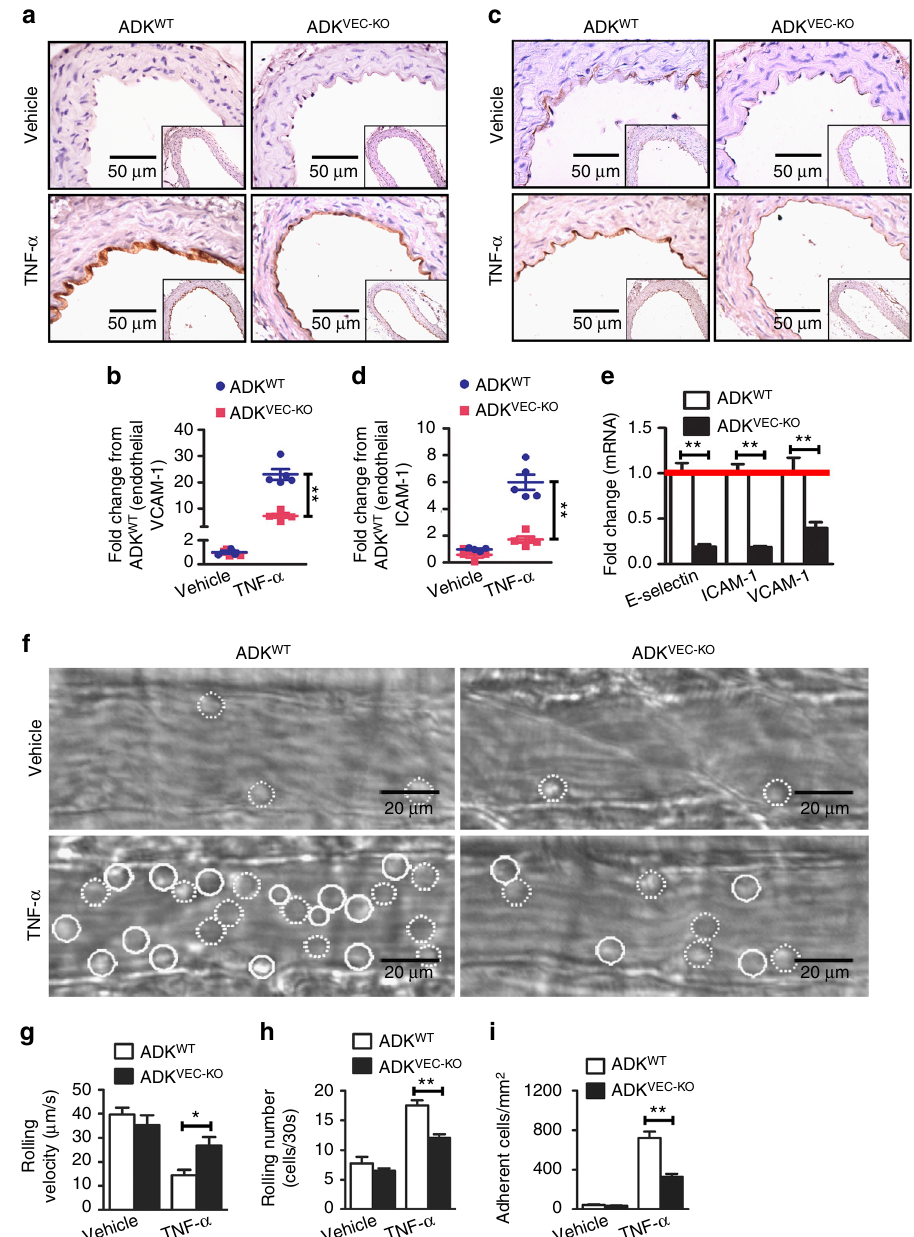
Fig. 3 ADK de fi ciency suppresses endothelial in fl ammation in vivo. a Representative images for immunohistochemical staining of VCAM-1 in aortas from TNF- α -treated ADK WT and ADK VEC-KO mice ( scale bar , 50 µ m). b Quanti fi cation of VCAM-1 expression in aortas from TNF- α -treated ADK WT and ADK VEC-KO mice and the graph shows the data as fold change compared with the vehicle-treated ADK WT mice ( n = 4 – 5 mice per group). c Representative images for immunohistochemical staining of ICAM-1 in aortas from TNF- α -treated ADK WT and ADK VEC-KO mice ( scale bar , 50 µ m). d Quanti fi cation of ICAM-1 expression in aortas from TNF- α -treated ADK WT and ADK VEC-KO mice and the graph shows the data as fold change compared with the vehicle- treated ADK WT mice ( n = 4 – 5 mice per group). e RT-PCR analysis of mRNA levels of adhesion molecules in aortas from TNF- α -treated ADK WT and ADK VEC-KO mice ( n = 5 mice per group). f Representative images of leukocyte rolling and adhesion on the endothelium of postcapillary venules in the cremaster muscles of vehicle or TNF- α -treated ADK WT and ADK VEC-KO mice. Rolling and adherent cells are indicated with dotted and solid circle line , respectively ( scale bar , 20 µ m). g Rolling velocity of leukocytes (at least 60 rolling leukocytes in 12 postcapillary venules of four mice per group). h Rolling number of leukocytes (at least 24 postcapillary venule segments in four mice per group). i Number of adherent leukocytes (at least 24 postcapillary venule segments in four mice per group). For bar graphs , data are the mean ± SEM, * P < 0.05 and ** P < 0.01 (unpaired, two-tailed Student ’ s t ADK binds with SAHH to facilitate the methylation of H3K4 . had no effect on the levels of H3K4me2 and H3K4me3 in either vehicle- or adenosine-treated HUVECs. Similar results In plants, ADK has been shown to bind SAHH, which enables the were observed in ADK KD cells (Fig. 4k and Supplementary rapid degradation of the adenosine produced by SAHH 17 . To Figs 5f, 6c, d). Altogether, these data suggest that adenosine investigate whether ADK and SAHH might interact in endothelial blocks H3K4 methylation via an intracellular mechanism. cells, co-immunoprecipitation (co-IP) assays were performed